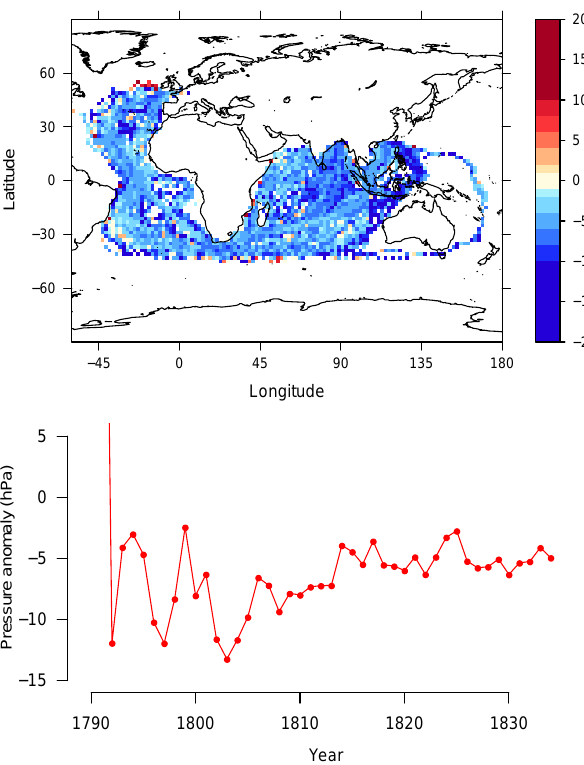
Fig. 5. Air temperature (AT) anomalies ( ◦ C): observations minus an air-temperature climatology for 1961–1990 (Rayner et al., 2003). Upper panel: truncated mean AT anomaly in each 2 × 2 degree square. Lower panel: truncated mean AT anomaly in each year. Note that the observed temperatures are not bias-adjusted.